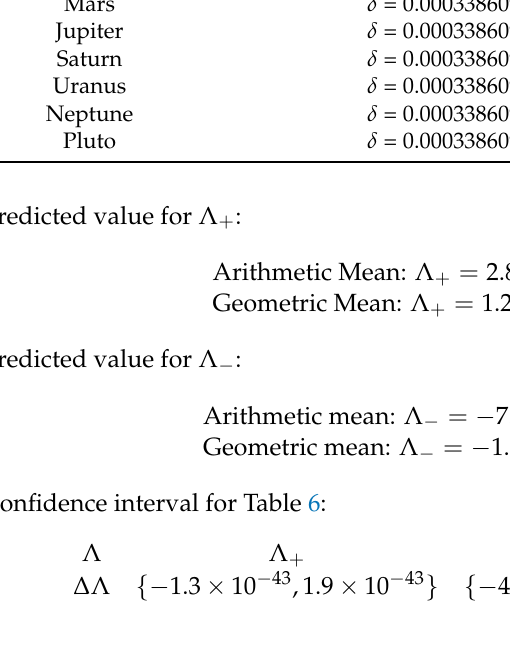
Table 6. Estimation of the cosmological constant using the second and third